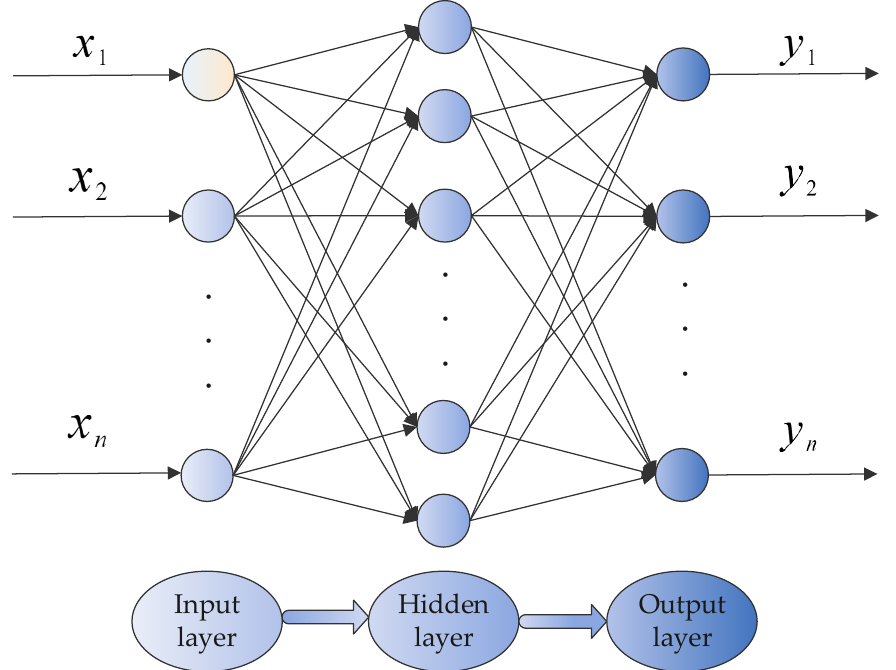
Figure 1. Basic structure of a typical back propagation neural network (BPNN). Typical loss function for optimization is shown in